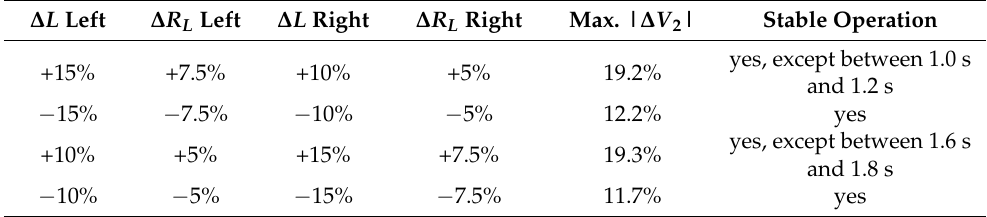
Table 12. Results of robustness analysis against variations of L and R L in Scenario #3.